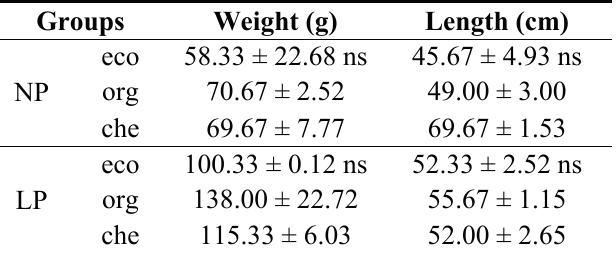
Table 5. Weight and length of